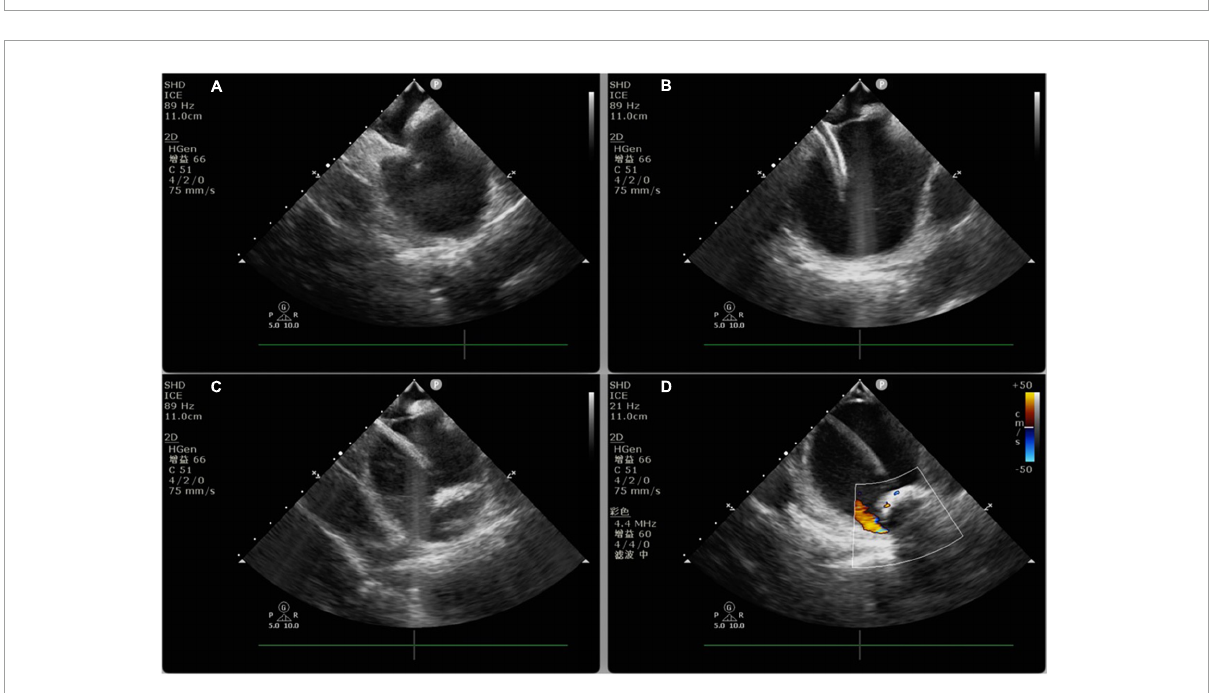
FIGURE2 Intracardiac echocardiography-guided cryoablation. (A) ICE-guided low transseptal puncture; (B) cryoablation sheath delivered through the low transseptum; (C) cryoballoon delivered into the left superior pulmonary vein under ICE guidance; (D) ICE color Doppler ultrasound applied to assess cryoballoon